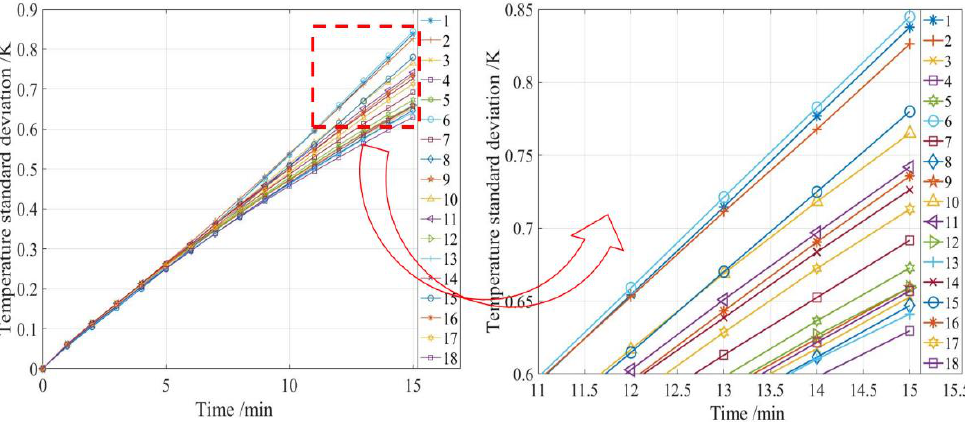
Figure 13. TSD of schemes for the battery pack with a single inlet and single outlet over time.